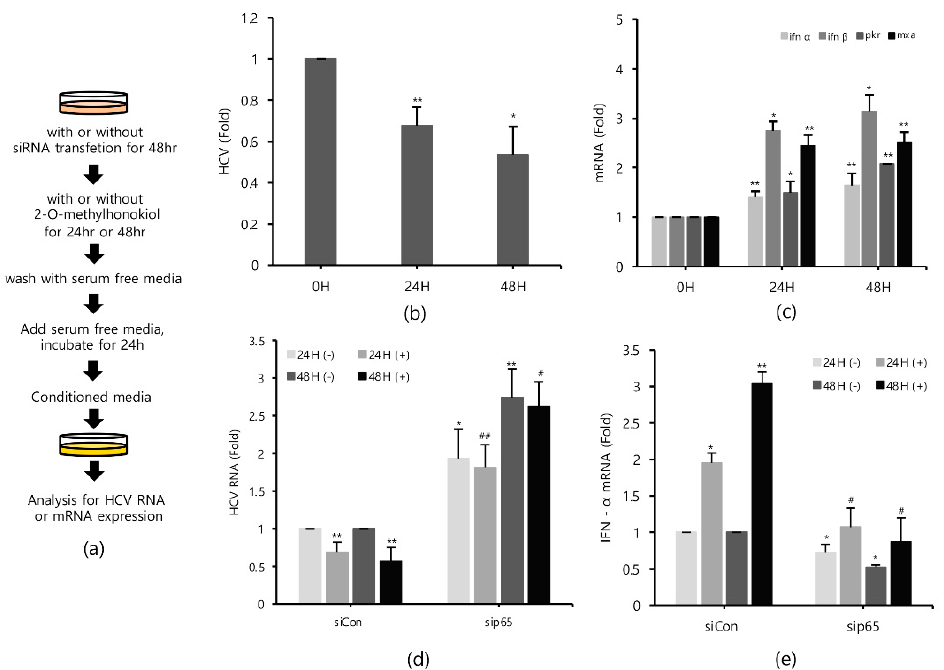
Figure 6. Conditioned media derived from 2-O-methylhonokiol-treated cells also suppresses HCV replication and activates innate immune responses. ( a ) Schematic of the experimental process. The conditioned medium cells were collected from the cell lines treated with 50 μ M 2-O-methylhonokiol. The levels of ( b ) HCV RNA, and ( c ) the indicated mRNAs, were measured by qRT-PCR, using the conditioned media-treated cell lines. After transfection with si-Con or si-RelA/p65 for 48 h, Huh7.5/Con1 cells were treated with or without 50 μ M 2-O-methylhonokiol for 24 or 48 h. The levels of ( d ) HCV RNA, and ( e ) IFN- α mRNA, were then analyzed by qRT-PCR, after treatment with 50 μ M 2-O-methylhonokiol for (24 or 48) h. The values are shown as the mean ± SD of three independent experiments. * p < 0.05, ** p <0.01 versus untreated control, or versus the untreated siCon-transfected control; # p < 0.05, ## p < 0.01 versus the 2-O-methylhonokiol-treated, siCon-transfected control; one-way ANOVA with Tukey’s multiple comparisons test.